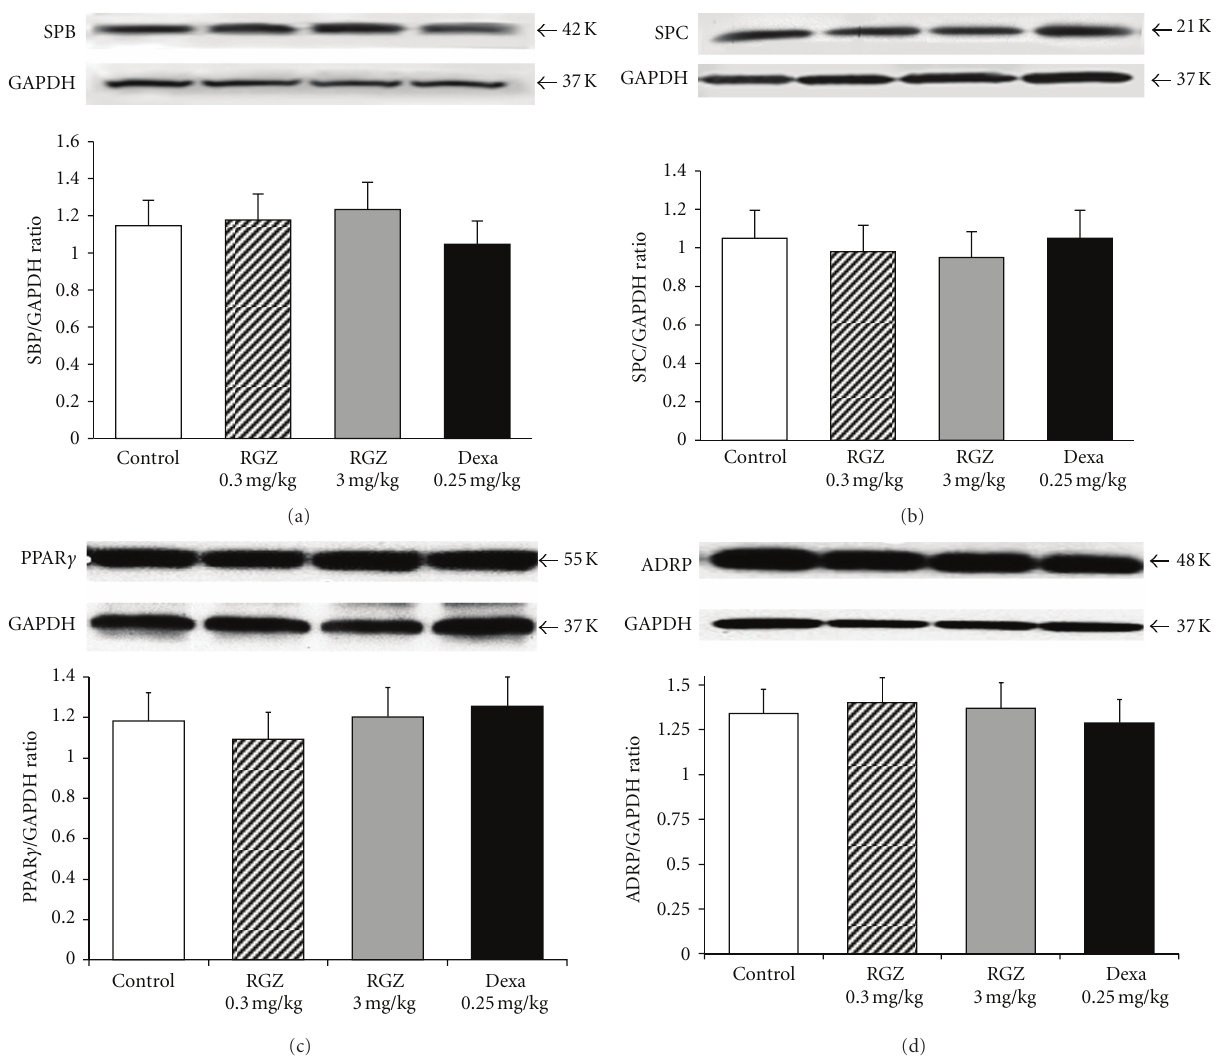
Figure 4: E ff ect of RGZ on SPB, SPC, PPAR γ , and ADRP expression in lung. Utilizing Western blot, SPB, SPC, PPAR γ , and ADRP levels were determined in lung lysates. There were no significant di ff erences ( P > 0 . 05) in protein levels of SPB (a), SPC (b), PPAR γ (c), or ADRP (d) in lung, in the RGZ- and dexamethasone- (Dexa-) treated groups compared with the controls. Representative Western blots and the corresponding density histograms are shown ( n = 4 in each